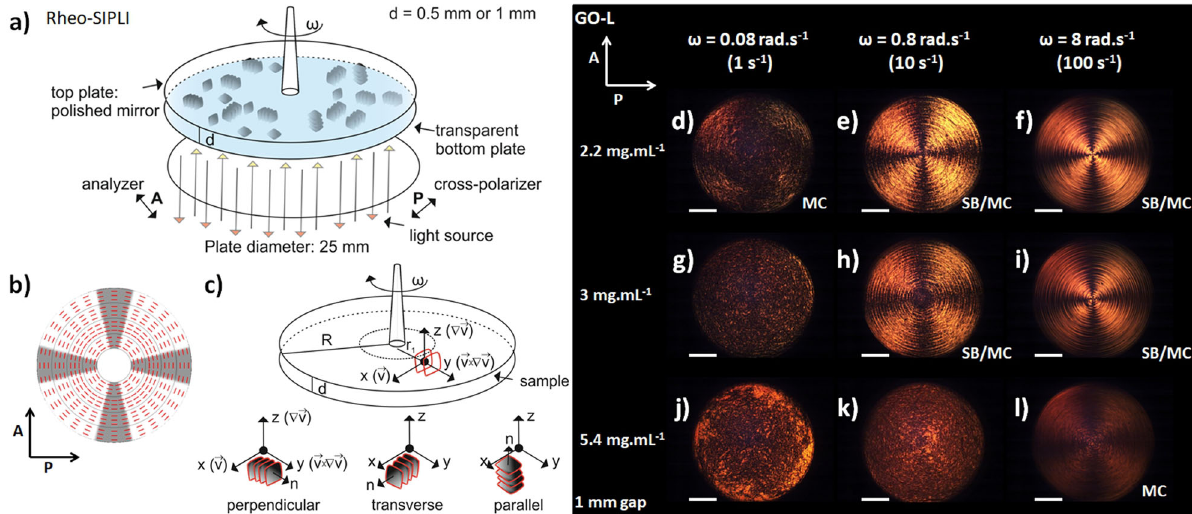
Fig. 1 GOLCs alignment phase state diagram using Rheo-SIPLI. a Schematic representation of the parallel-plate shear geometry used for Rheo-SIPLI. The diameter of the top plate used was kept at 25 mm. The double-sided arrows show plane of polarization of the polarizer (P) and the analyzer (A) perpendicular to each other. The angular speed ( ω ) indicates the axis and direction of rotation of the top shear plate. b A schematic representation of GO fl ake alignment directions in the parallel-plate geometry (top-view) with a corresponding Maltese Cross pattern which could be observed for this alignment in polarized light images, the arrows show plane of polarization of P and A. c Possible GO fl ake orientations in the parallel-plate shear geometry used for Rheo-SIPLI (parallel, perpendicular, and transverse) schematically depicted with respect to the shearing directions. In the cylindrical coordinate system employed here, x, y, and z correspond to fl ow, vorticity, and shear gradient direction, respectively. The GO fl ake orientation is denoted by the normal vector to the fl ake surface. d – l SIPLIs of GO-L dispersion at three concentrations (indicated by the left column) using different angular speed of rotation (indicated by the top line, shear rates produced at the sample edge are shown in brackets), captured at the end of a 120 s shear pulse. The shearing plates were set at 1 mm gap. SB and MC indicate that apparent vorticity shear banding (SB) and/or Maltese Cross (MC) is observed. The diameter of the polarized light images is 25 mm (corresponding to the diameter of the top plate). Scale bar on SIPLIs depicts 5.86